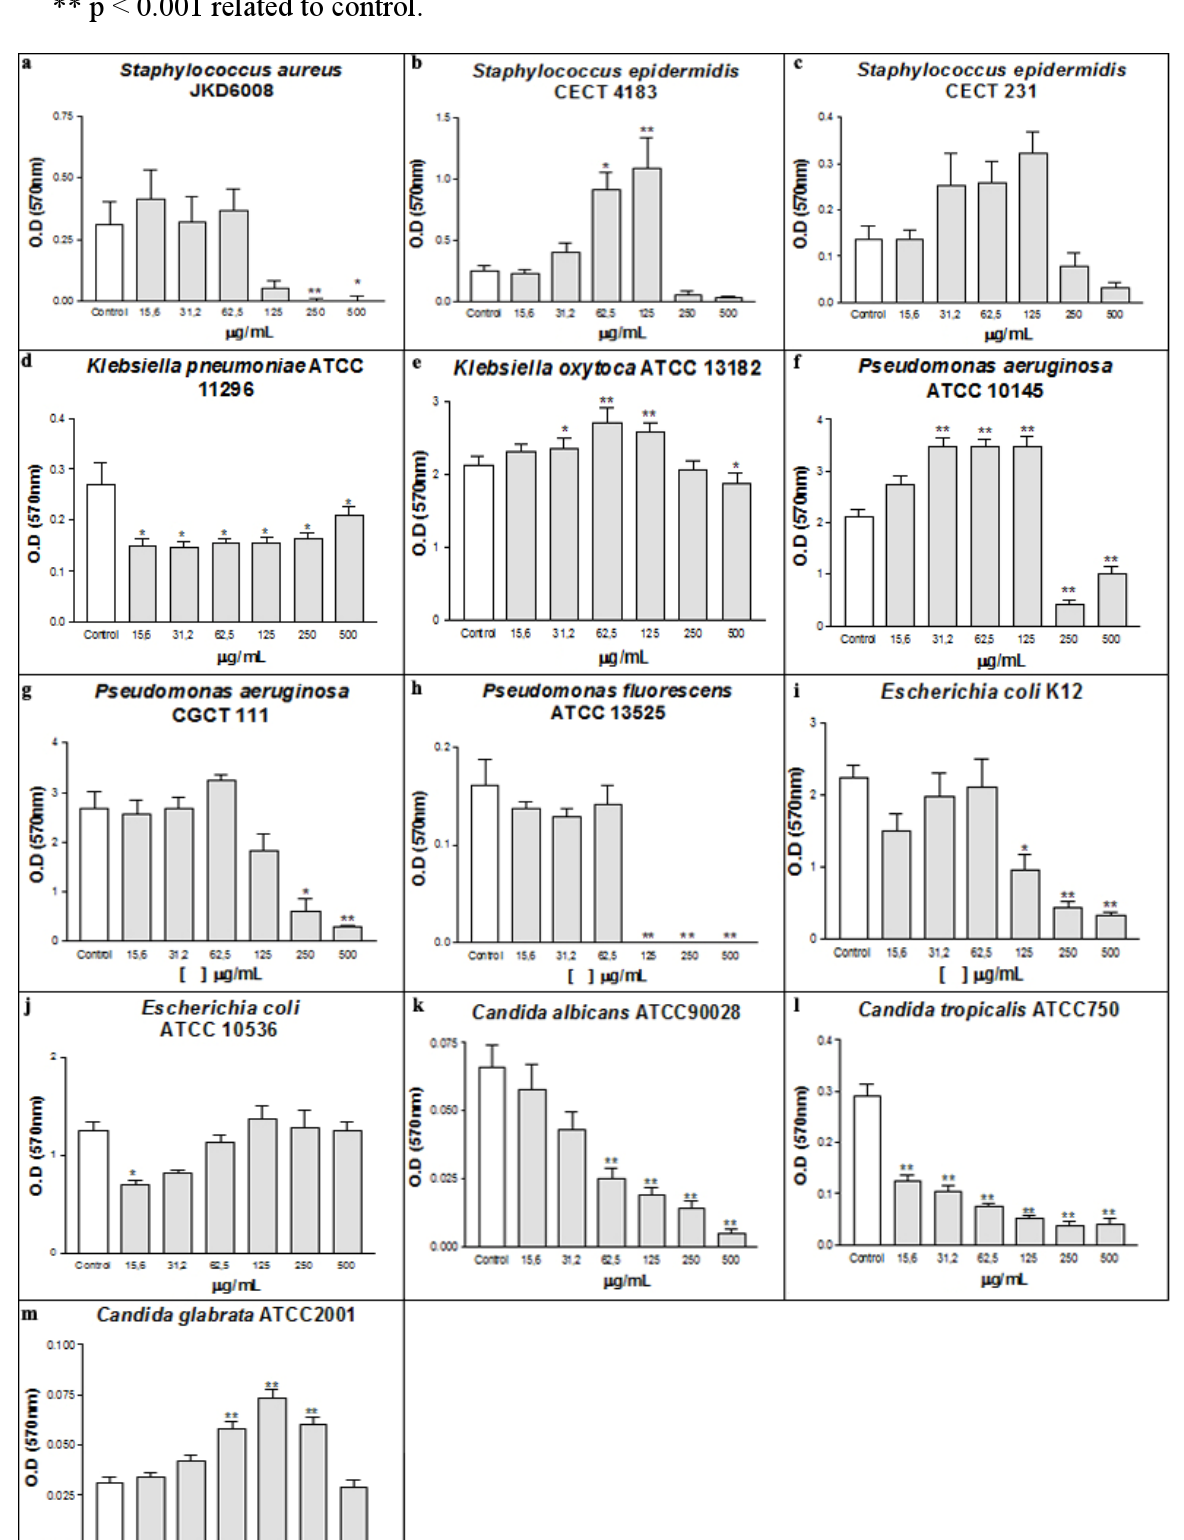
Figure 2. Antibiofilm effect of CD on bacterial (a-j) and yeasts (k-m). *p < 0.01 and ** p < 0.001 related to